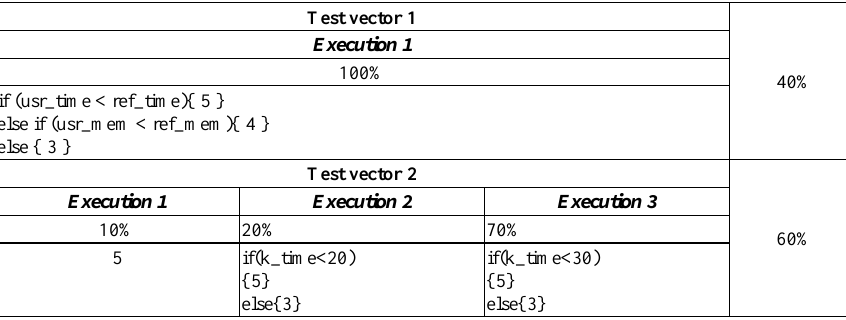
Table 3. Example of grading weights and cost